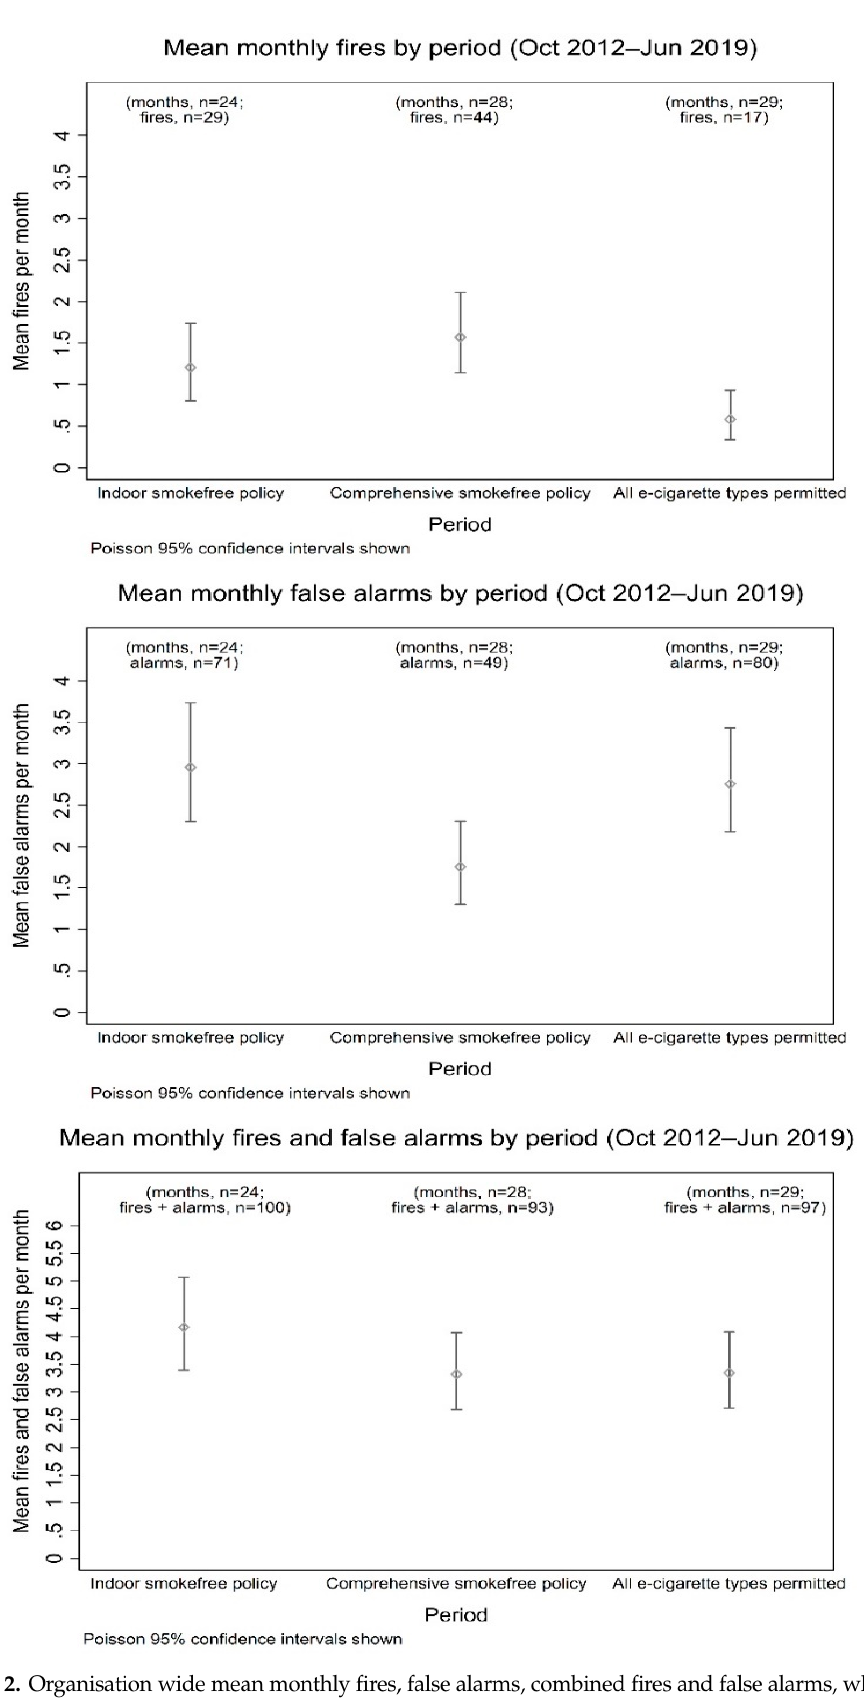
Figure 2. Organisation wide mean monthly fires, false alarms, combined fires and false alarms, while the indoor only smokefree policy, comprehensive smokefree policy and permitted use of all types of e-cigarettes were in effect.